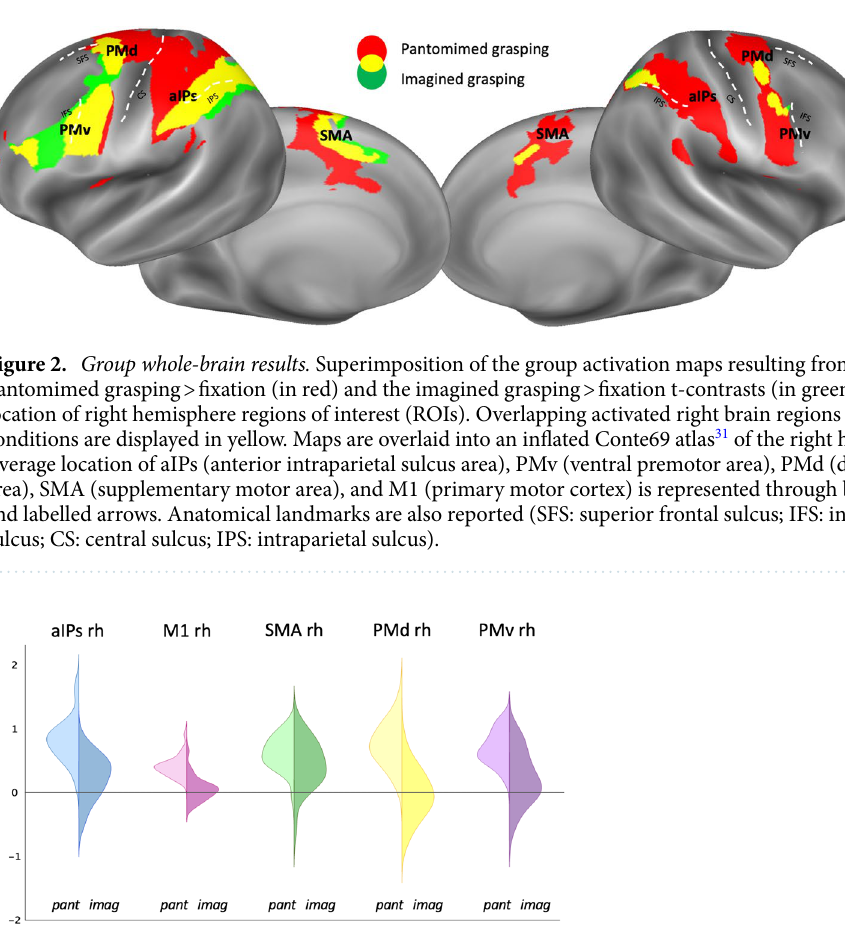
Figure 3. Plots of the activations of the right regions of interest (ROIs) in the pantomimed grasping and imagined grasping conditions. Violin plots showing the distribution of the activation of the selected ROIs across subjects are displayed for each right-hemisphere region, i.e., aIPs (blue), M1 (pink), SMA (green), PMd (yellow), and PMv (purple). The left side of the violins represents the pantomimed grasping condition (“pant”), and the right side the imagined grasping condition